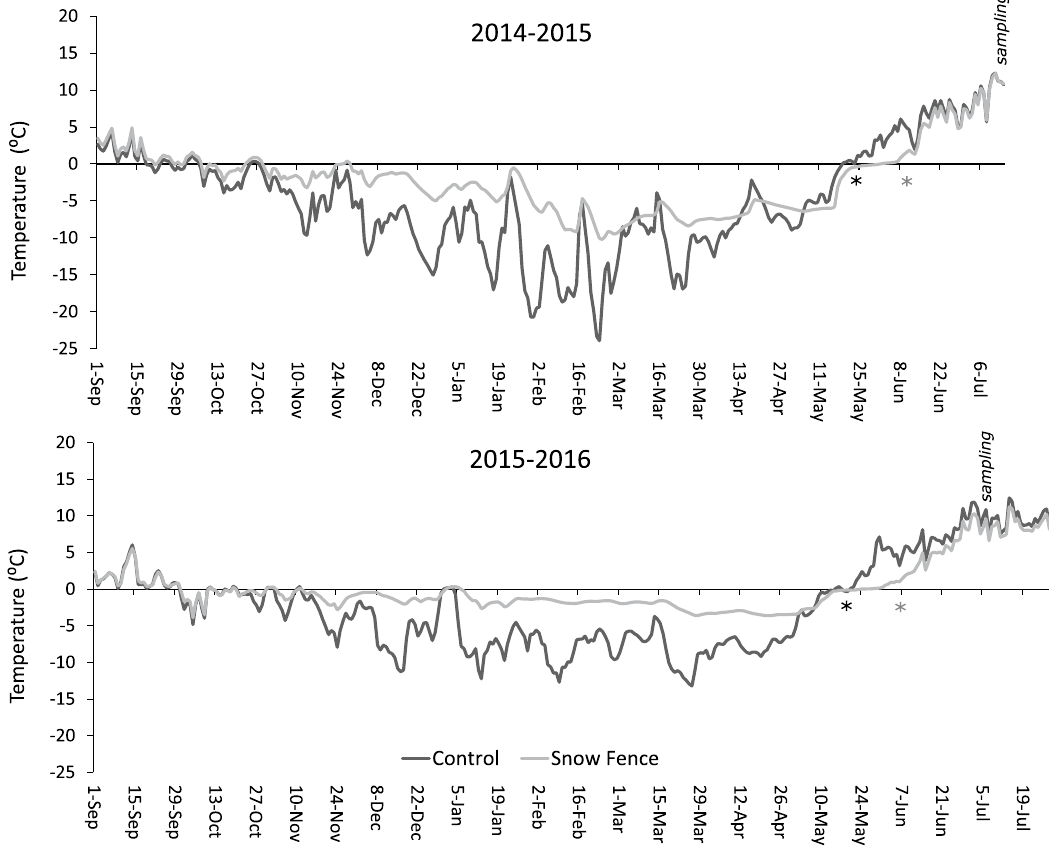
Figure 1. Average soil temperature (1 cm depth) during autumn-early summer in 2014–2015 and 2015–2016 in unmanipulated, ambient (Control, max ~ 35 cm snow) plots and increased snow depth plots (Snow fence, max > 1 m snow) (Number of replicate loggers: 9). Asterisks indicate approximate snowmelt date for ambient (black) and snow fence plots (grey). Experimental site was located at Adventdalen,